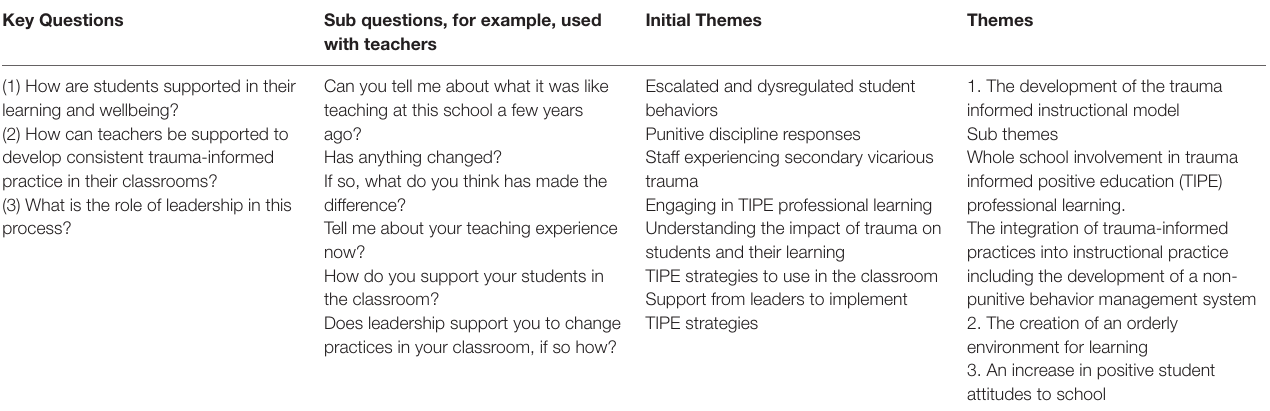
TABLE 1 | Summary of key questions and